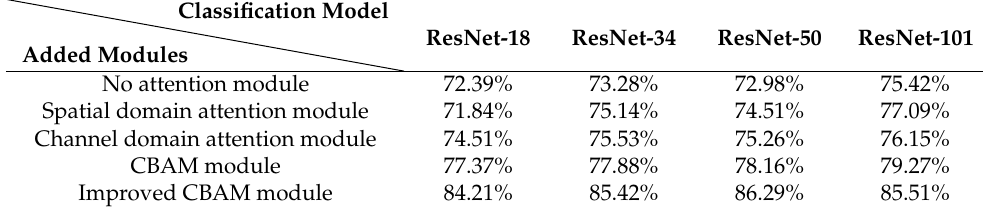
Table 8. Recall rates of classification models under each attention mechanism.